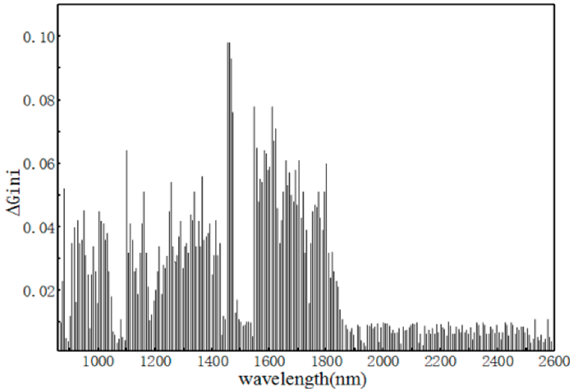
Figure 15. Nitrogen content of soil samples based on random forest with 256-wavelength ∆ Gini variation.